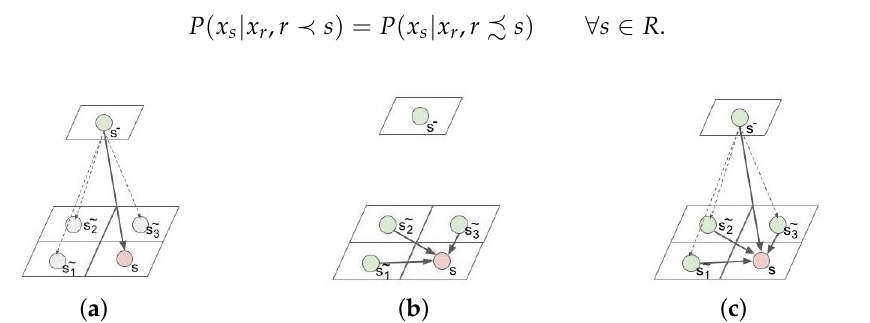
Figure 2. Causal models of ( a ) a hierarchical Markov random field (MRF), ( b ) a Markov mesh, and ( c ) the proposed symmetric Markov mesh random field (SMMRF)-based